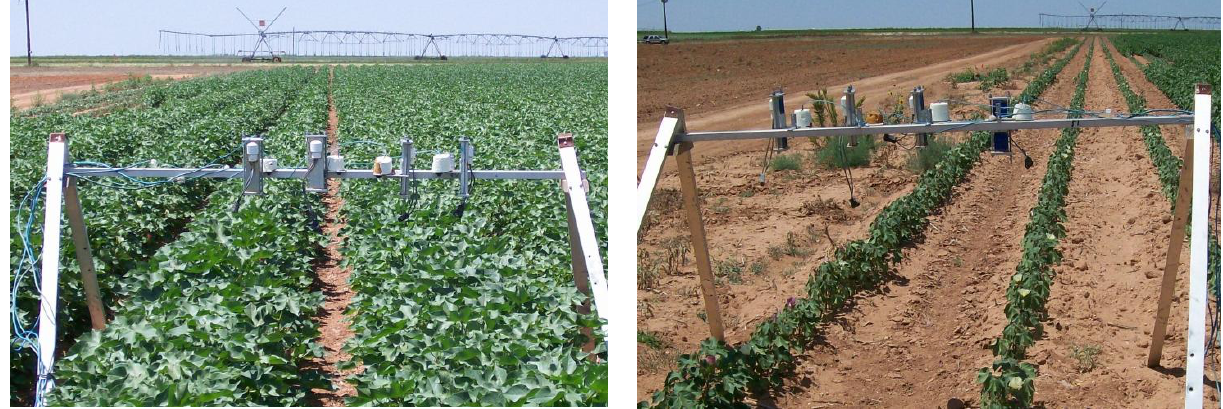
Figure 2. Array of sensors used to monitor surface temperature ( Ts ): ( left ) high irrigation treatment; ( right ) dryland